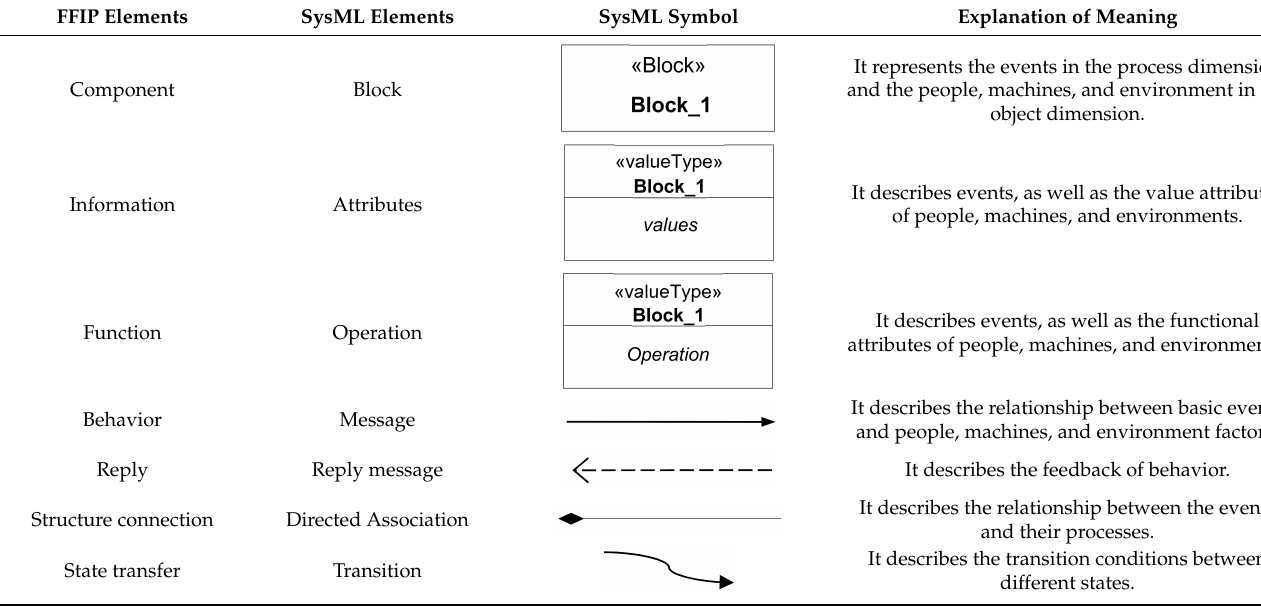
Table 3. Mapping relationship between FFIP elements and SysML